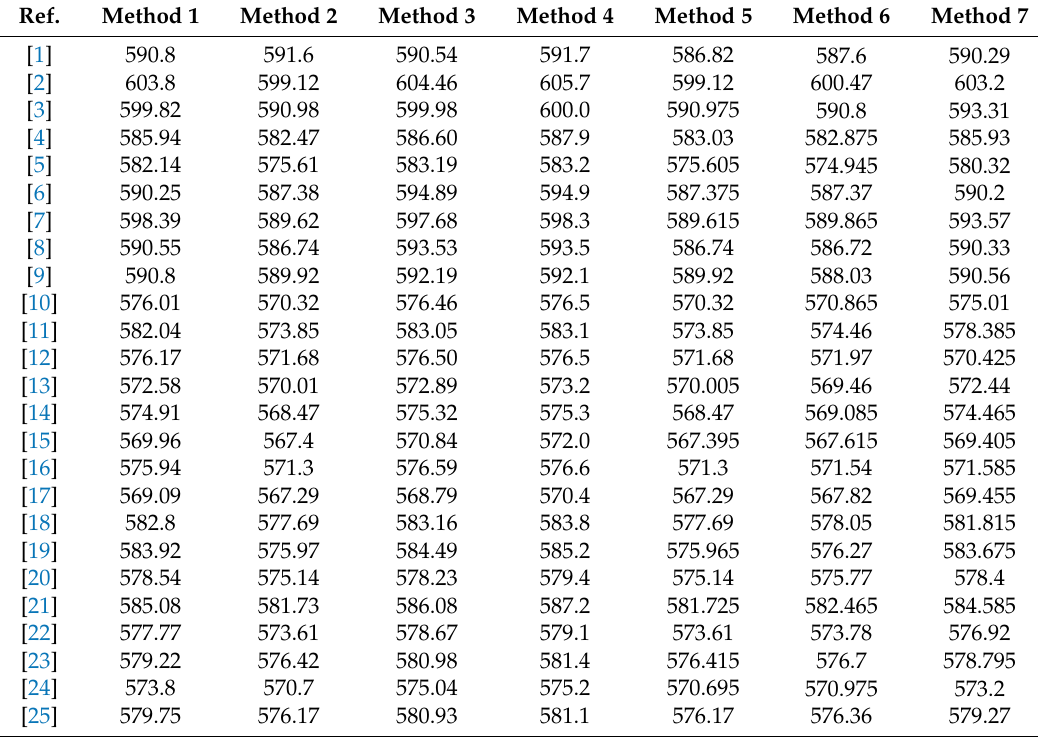
Table 2. The DCP temperature values of the studied alloys DCP ( ◦ C).